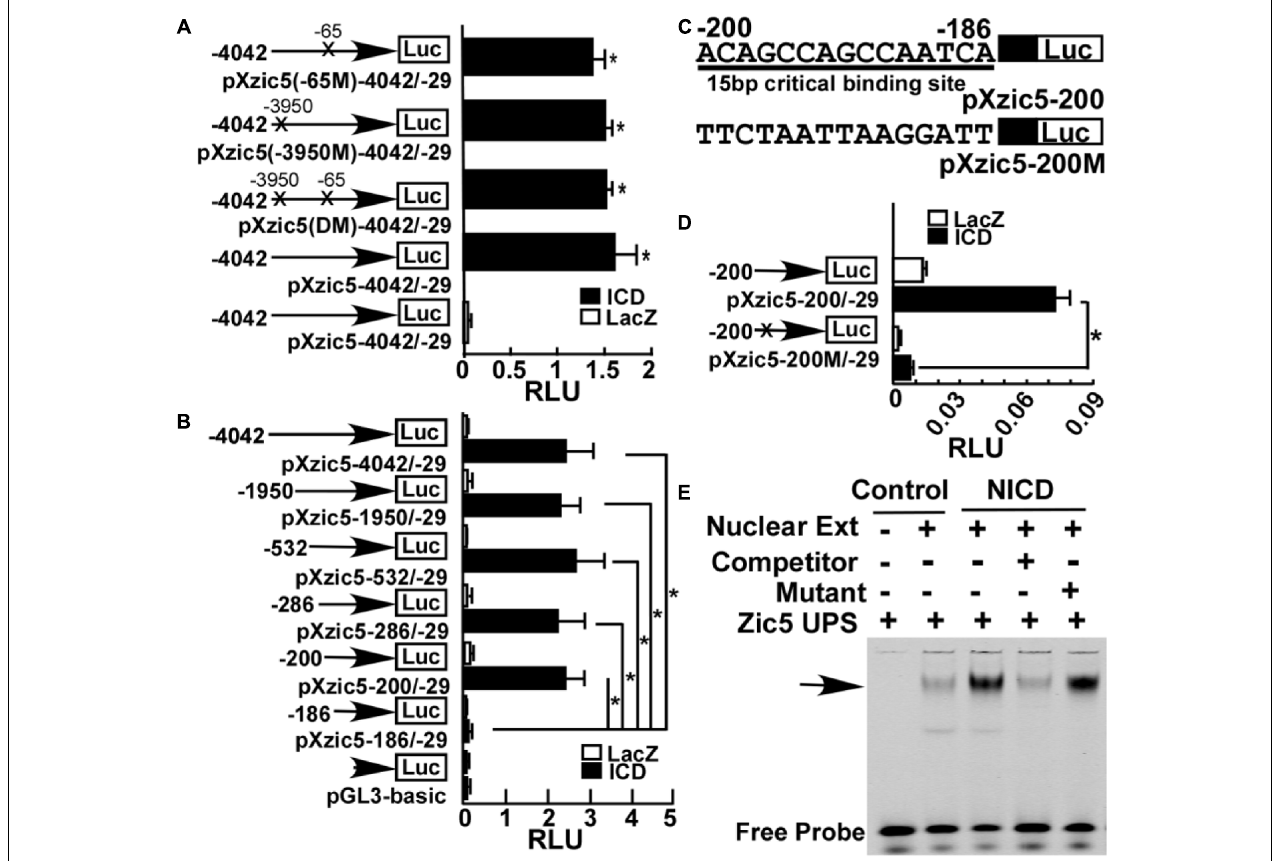
FIGURE 5 | Identification of a novel NRE in Xenopus Zic5 . (A) A ∼ 4 kb region (-4042 to -29) upstream of Zic5 contains a Zic 5 promoter. Mutations of two putative canonical CSL binding sites within this 4 kb region did not affect notch’s activation of promoter activity. X’s represent the mutated site. (B) Deletion assay of Zic5 upstream regulatory sequence identified a 15 bp NRE locating between -200 and -186 bp in response to NICD activation. P -values relative to -186/-29 fragment are -200/-29 ( P = 0.004); -286/-29 ( P = 0.015); -533/-29 ( P = 0.013); -1950/-29 ( P = 0.004); -4042/-29 ( P = 0.014). (C) Diagram of the constructs containing 15 bp CSL sequence and mutations in the promoter constructs. pXZic5-200 represents the wild-type and pXZic5-200M represents the 15 bp CBS mutant plasmid. (D) Mutation of the 15 bp CBS (pXZic5-200M) abolished the activation triggered by NICD in the reporter assay; P = 0.0017. (E) EMSA assay; NICD expression increased protein binding to the 15 bp NRE (see section “Materials and Methods”). The number represents Mean ± SEM, N = 3, ∗ P < 0.05 with the post hoc Newman–Keuls test. RLU, relative luminant unit; Nuclear Ext, nuclear extraction; Zic5 UPS, fluorescent-labeling zic5 upstream Notch response